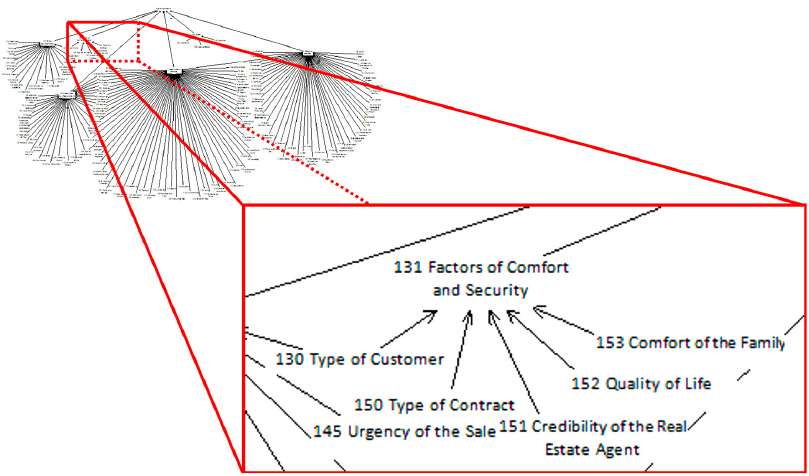
Fig. 3. Final version of the collective cognitive